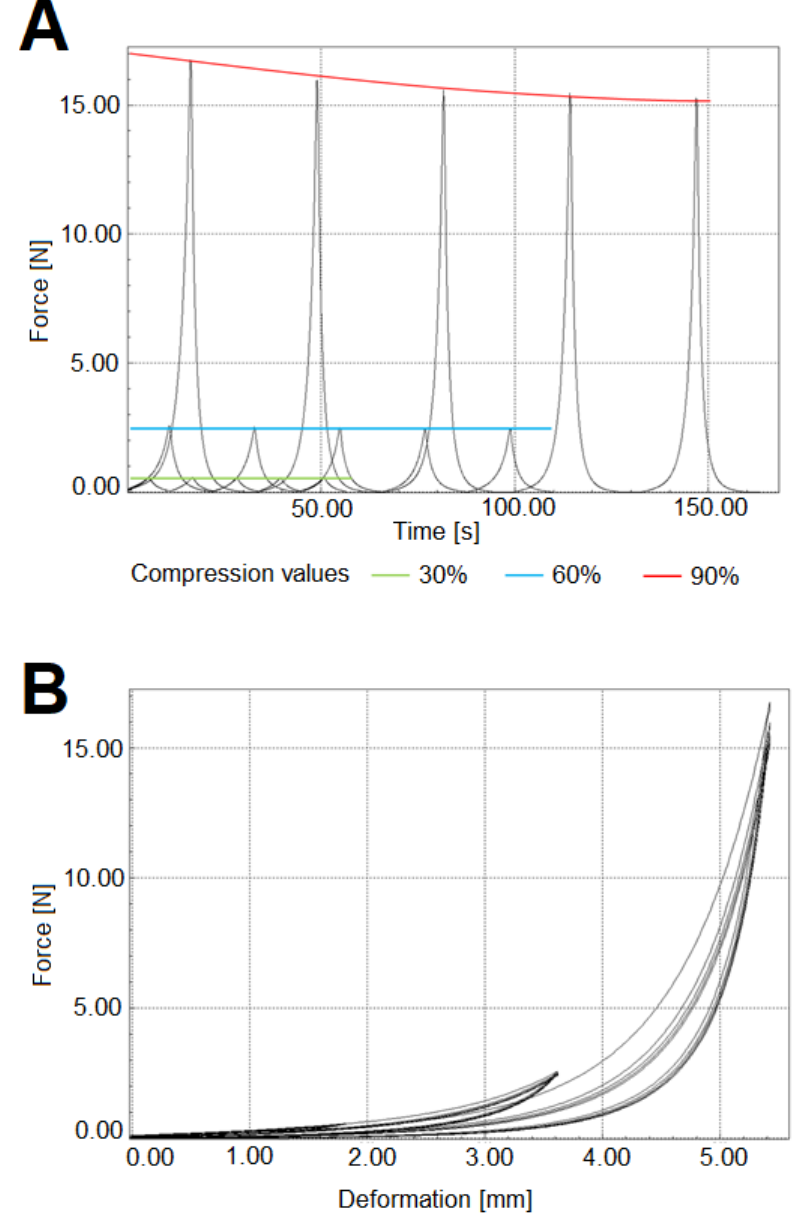
Figure 12. Measurement of cyclic deformation. ( A ) The testing of reversible cyclic deformations of PCL scaffolds at sample compression values 30, 60, and 90%. ( B ) The deformation curves of cyclic deformations testing at sample compression values of 30, 60, and 90%.